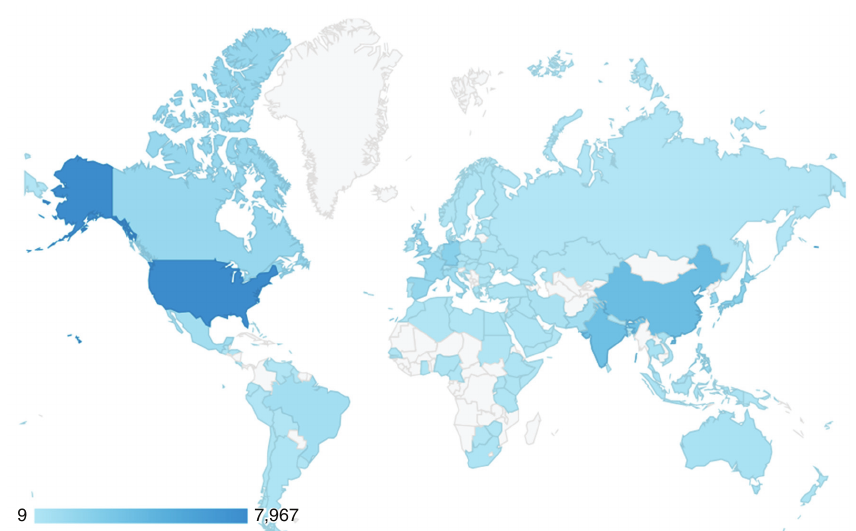
Figure 1. Geographic distribution of Teaching Tools pageviews during 2014, provided by Google Analytics. More than 100 countries are represented in the more than 250,000 pageviews accrued during 2014. Since 2011, the US, China and India have been the countries with the largest number of